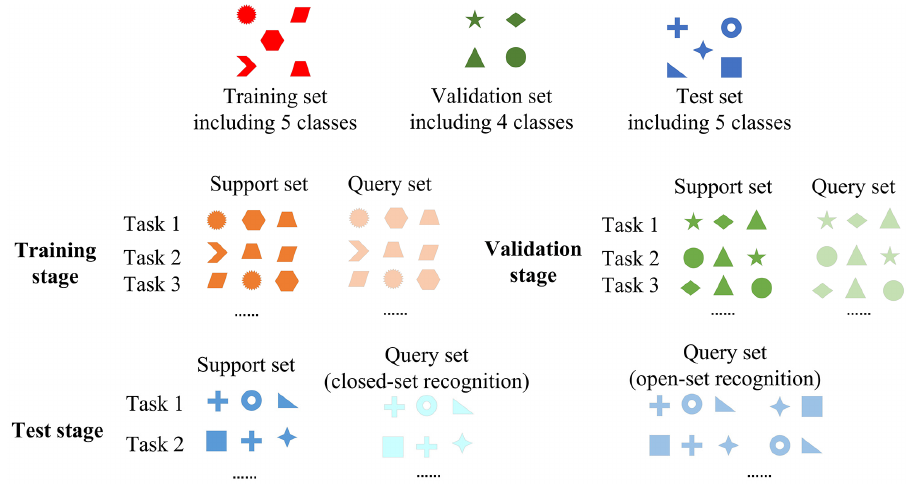
Figure 2. The formulation of the training set, validation set, and test set, and the method of obtaining tasks. There is an example under the condition as follows: the training set includes 5 types of samples, the validation set includes 4 types of samples, the test set includes 5 types of samples, and 3-way 1-shot tasks are randomly sampled, that is, X = 5, Y = 4, Z = 5, N = 3, K = J = 1.